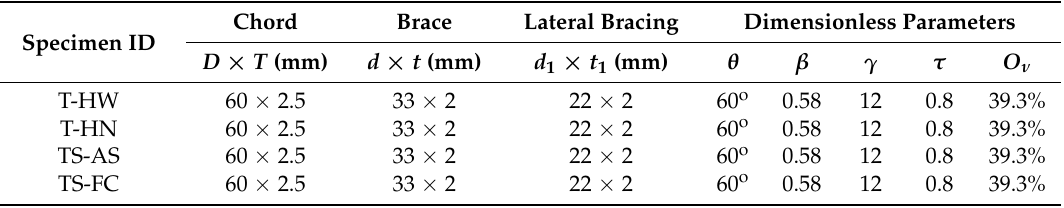
Figure 1. Warren circular hollow section (CHS) tubular truss. ( a ) Front view of the tubular truss (mm); ( b ) Top view of the tubular truss (mm); ( c ) Joints detail of the tubular truss. Table 1. Geometric parameters of